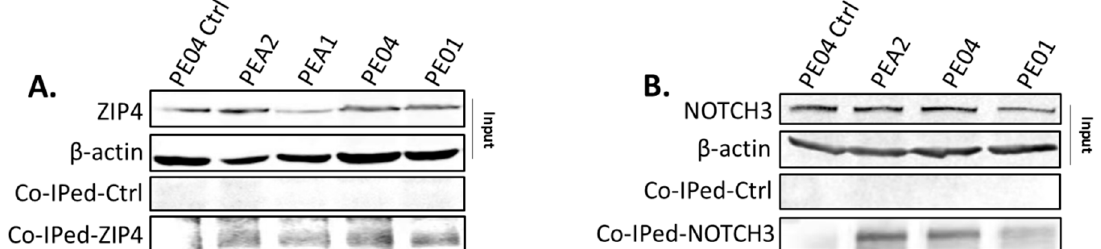
Figure 6. Physical interaction between ZIP4 and NOTCH3 ( A ) coimmunoprecipitations (IPs). The top rows: input before co-IP with β -actin as a loading control in the second row. The third and the fourth rows: Western blot to detect ZIP4. The third row shows results from the negative controls: first lane: no antibody bound to the bead and PE04 cell lysate was used; second to the fifth lanes: IgG (anti-human IgG antibody (ab109489, Abcam, Cambridge, MA, USA) was bound to beads and lysates from di ff erent cell lines were used. The fourth row shows the ZIP4 co-IPed by the NOTCH3 antibody from di ff erent cell lysates. ( B ) Reverse co-IP was performed by a ZIP4 antibody (20625-I-AP), followed by Western blot analysis to detect NOTCH3. The top two rows show the input with β -actin as a loading control in the second row. The third and the fourth rows: Western blot to detect NOTCH3. The third row shows the results from negative controls: first lane: no antibody bound to the bead and PE04 cell lysate was used; second to the fourth lanes: IgG was bound to breads, and lysates from di ff erent cell lines were used. The fourth row shows the NOTCH3 co-IPed by the ZIP4 antibody from di ff erent cell lysates. Pierce Cross-link IP Kit was used. Representative results are shown for more than three independent experiments. The uncropped Western blot images for (A) and (B) are shown in the Figure S2.